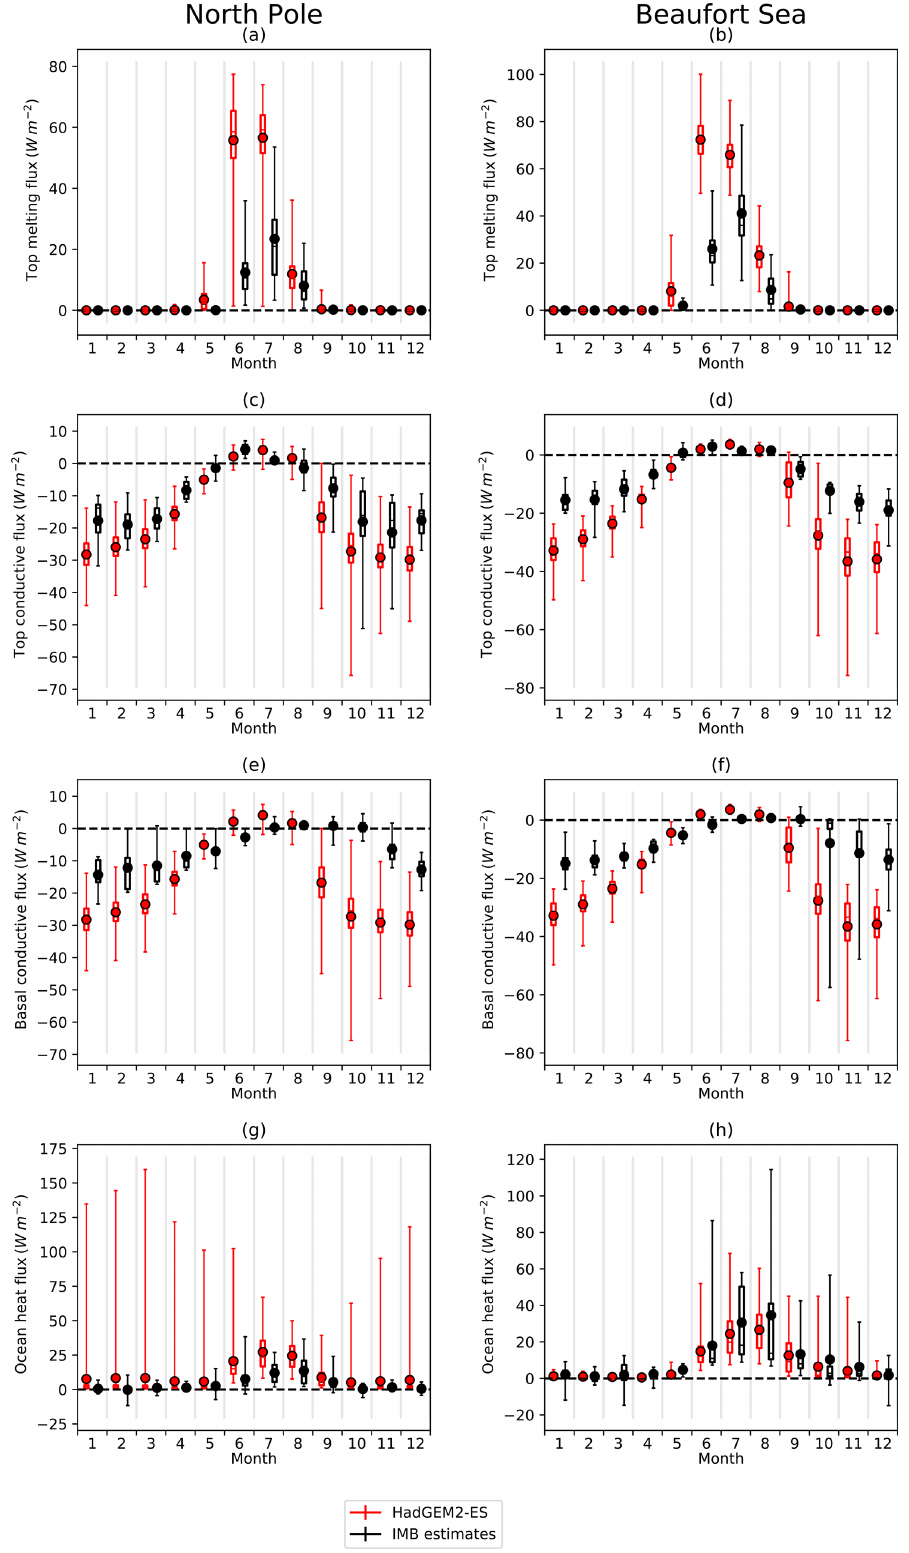
Figure 9. Comparing distribution of (a, b) top melt, (c, d) top conductive flux, (e, f) basal conductive flux and (g, h) ocean heat flux from HadGEM2-ES (red) to those estimated from the IMB data (black), for the (a, c, e, g) North Pole and (b, d, f, h) Beaufort Sea